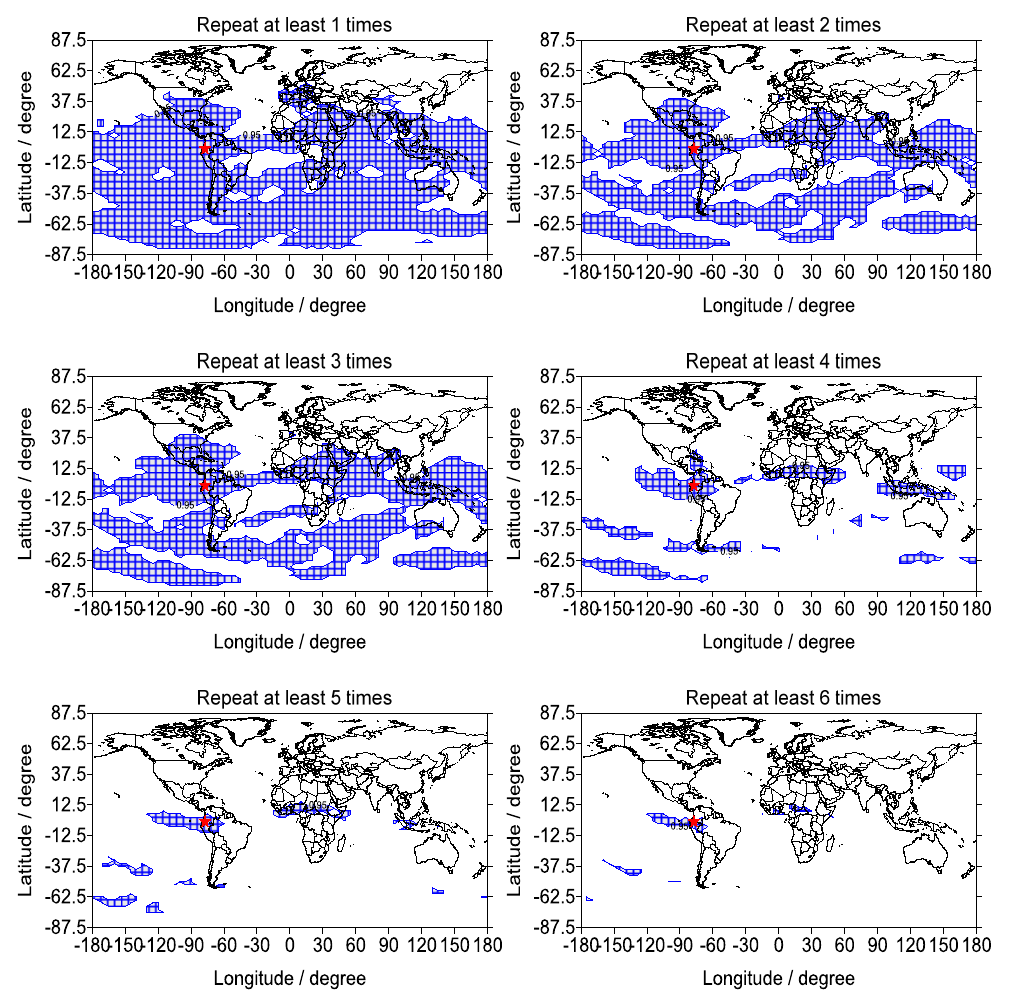
Fig. 11. Locations of the 30-day extreme enhancement that repeatedly appeared at various time points on 12 August 2010.